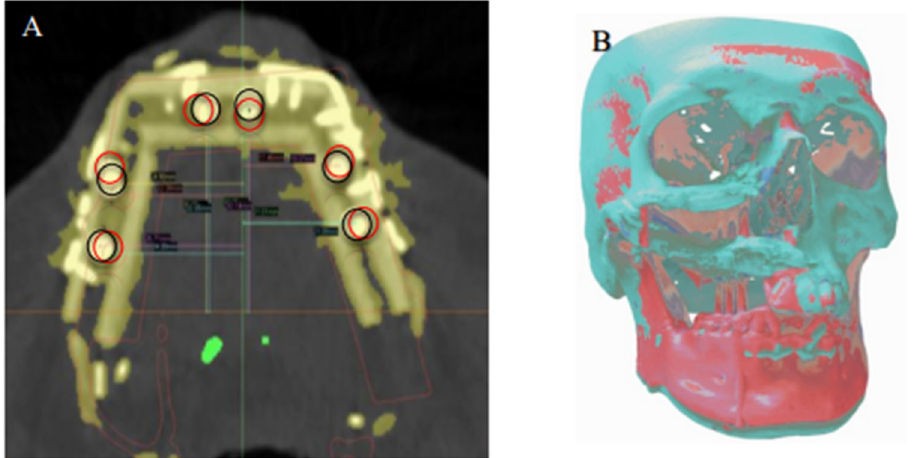
Figure 7. ( A ) Superimposition of the planned (black circles) dental implant locations according to virtual reconstruction planning and actual (red circles) implant locations on the postoperative CT. ( B ) Registration of the preoperative 3D model and the postoperative 3D reconstruction, showing overall deviation from the virtual plan.